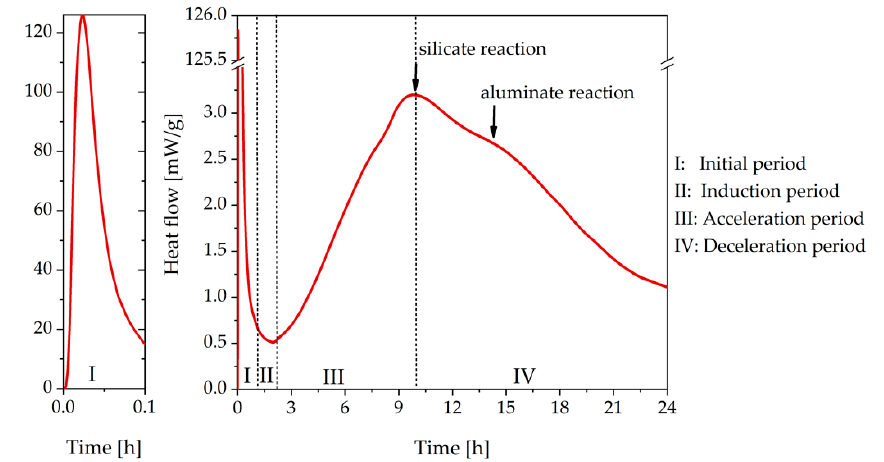
Figure 1. Heat flow curve of CEM I measured by calorimetry with internal mixing (water/cement, w/c = 0.36) .